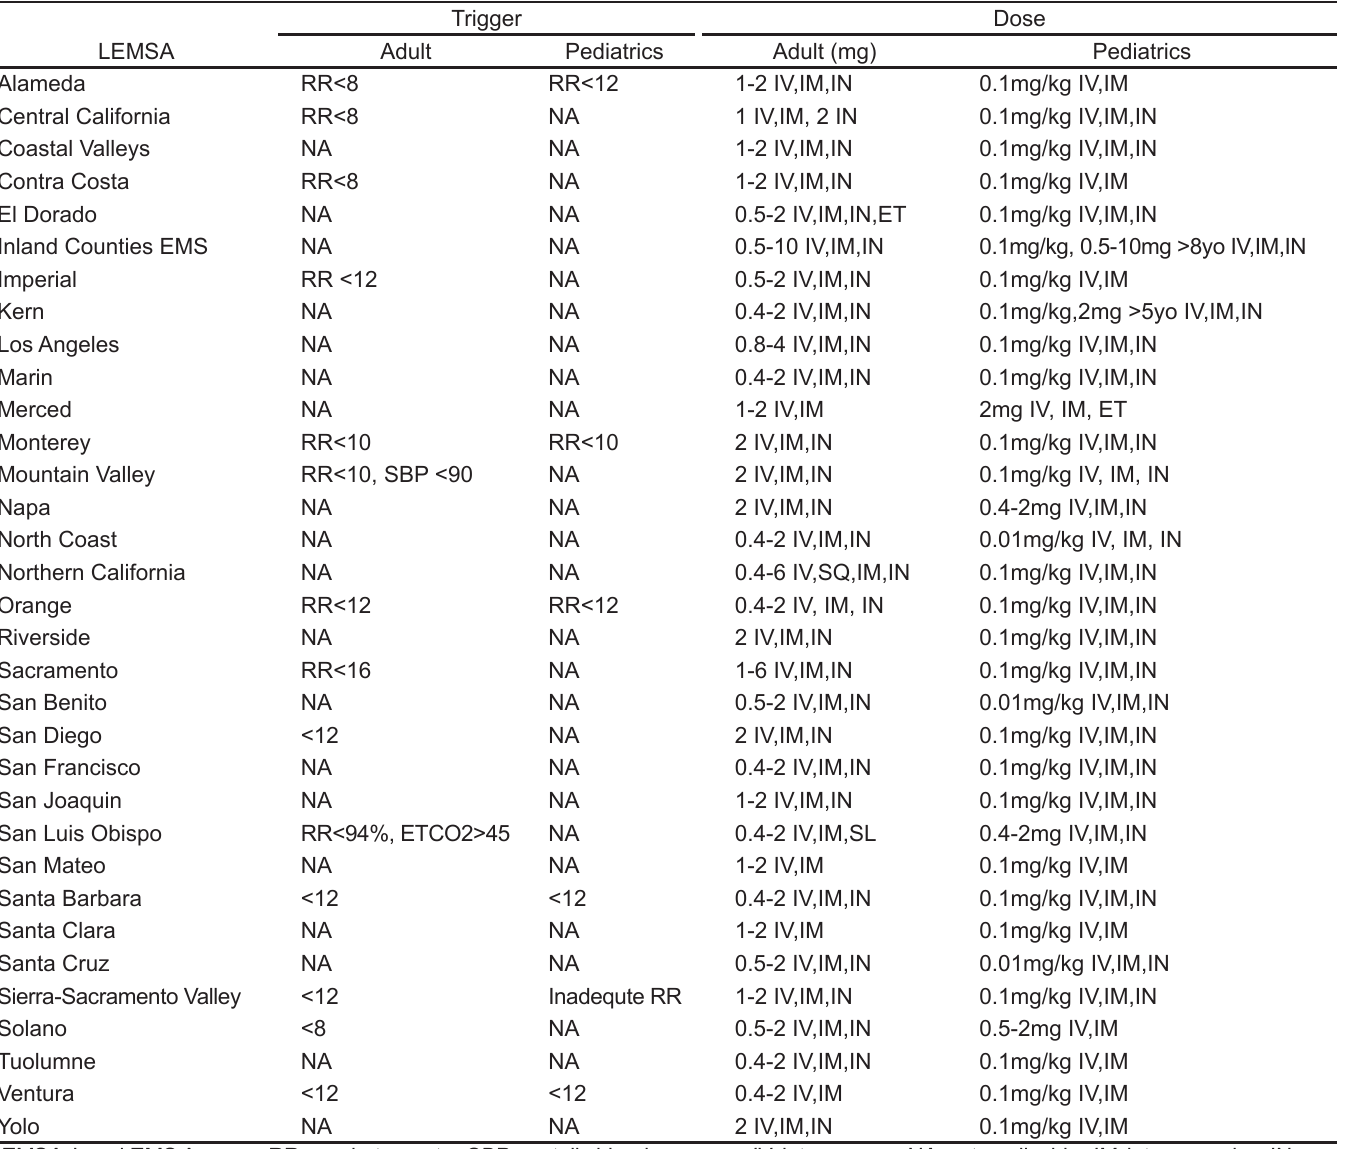
Table 2. Naloxone criteria and suggested